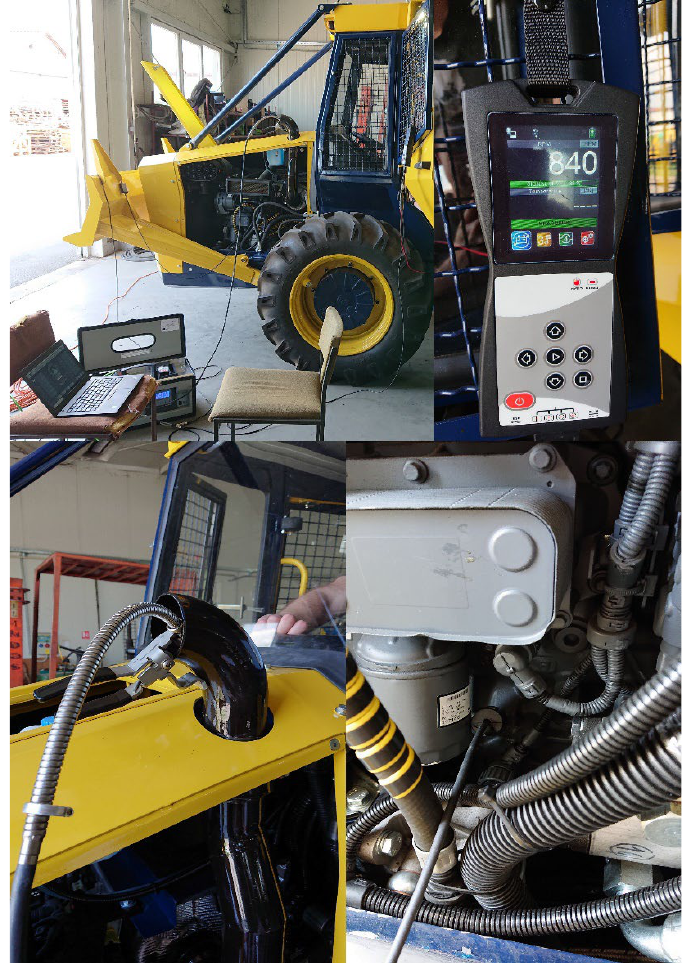
Figure 2. Measurement rig.